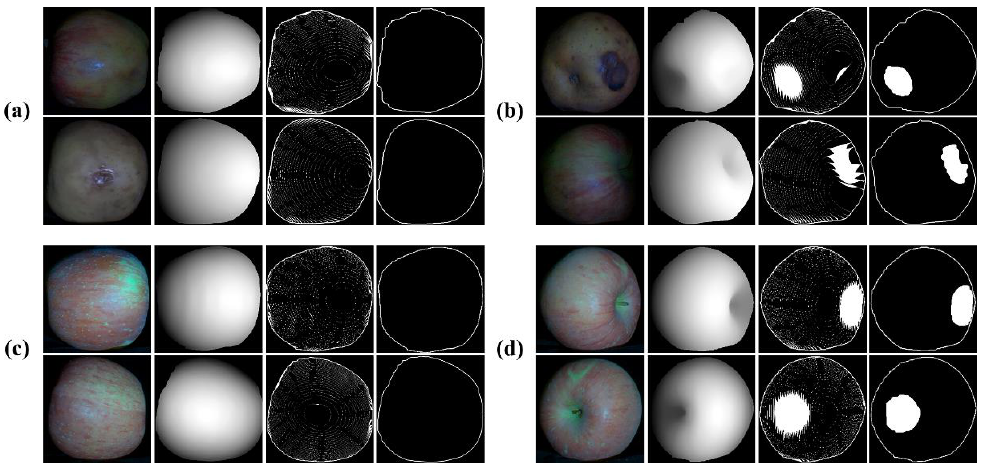
Figure 6. Stem and calyx recognition results. ( a ) Apple images with defects but no apparent stem and